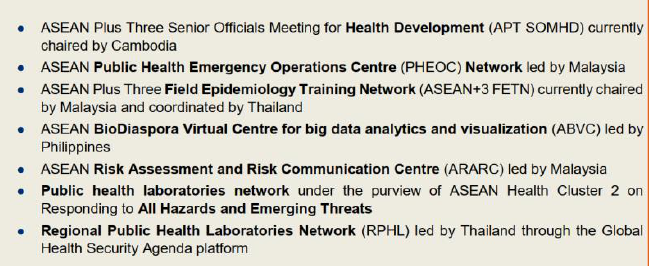
Figure 2. The ASEAN mechanism to respond to the COVID-19 pandemic [5].